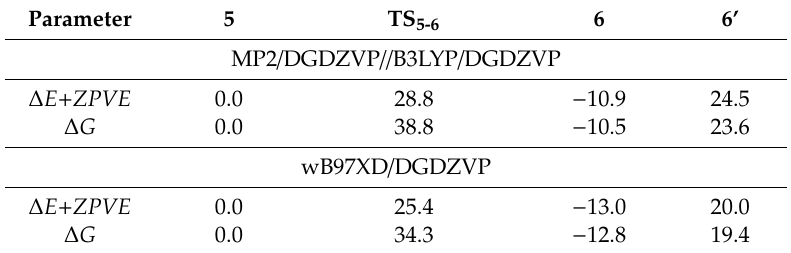
Table 1. Relative energies (kcal / mol) of molecules 6 and 6’ formed in the system Bu t OCl +